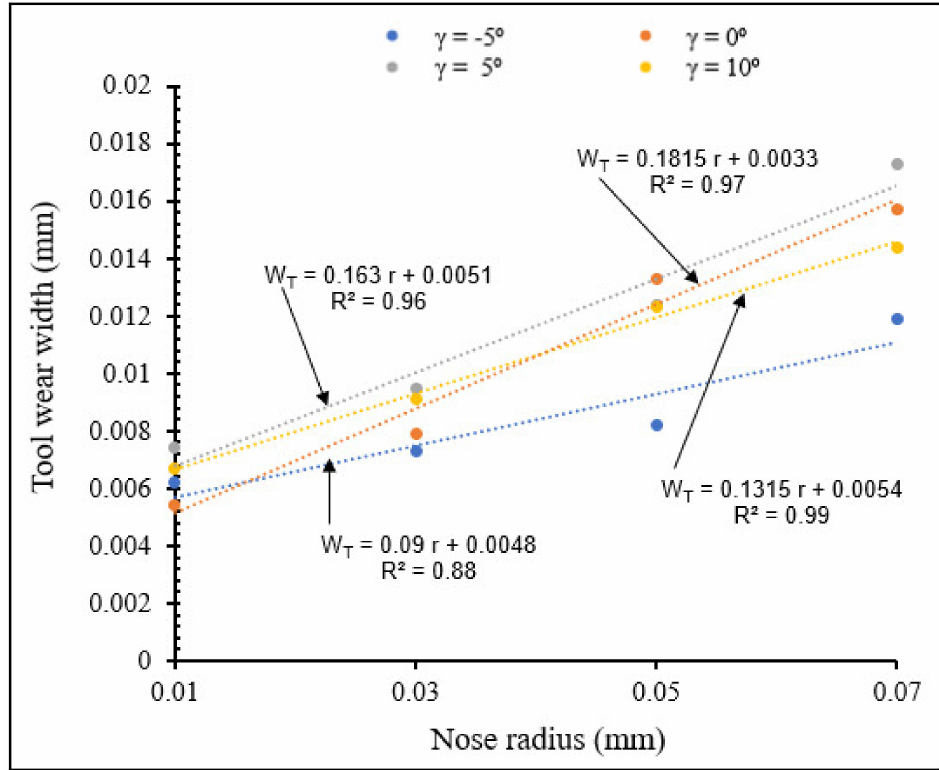
Figure 26. Variation of tool wear width with nose radius for different rake angles at V = 104 m/min, f = 0.1 mm/rev.